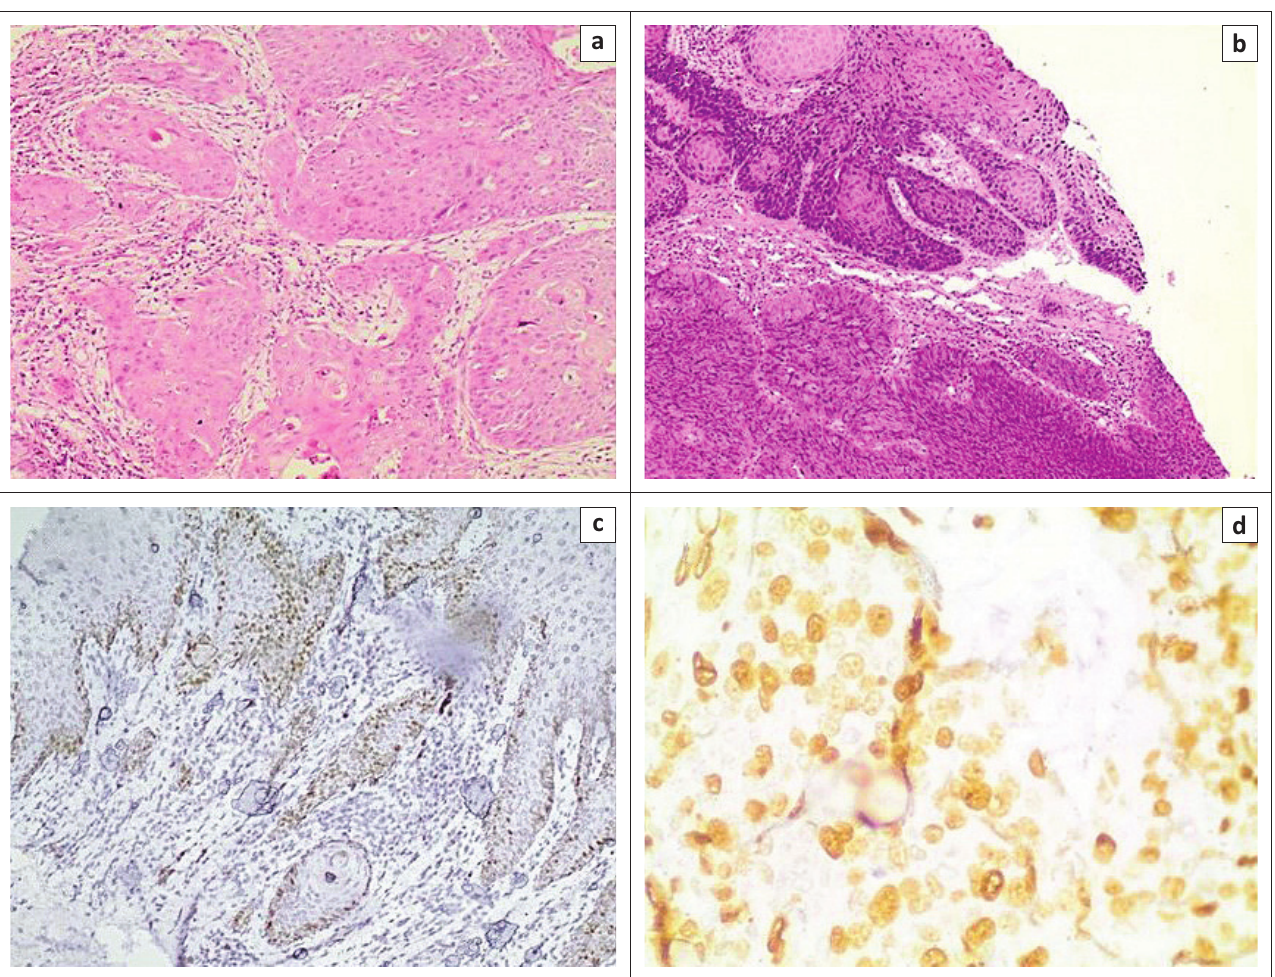
FIGURE 2: P53 and Ki-67 immunostaining photomicrographs of warty vulvar squamous cell carcinoma and basaloid vulvar squamous cell carcinoma among women attending the University Teaching Hospital, Zambia, 2018. (a) Warty vulvar squamous cell carcinoma: Nests of malignant squamous cells are noted surrounded by a desmoplastic stroma . (b) Basaloid vulvar squamous cell carcinoma: Sheets of cells with hyperchromatic nuclei and scant to no cytoplasm are seen with overlying atypical surface epithelium. (c) P53 immunostaining in warty vulvar squamous cell carcinoma. Focal staining is noted. (d) Ki-67 stain. A diffuse nuclear staining pattern is